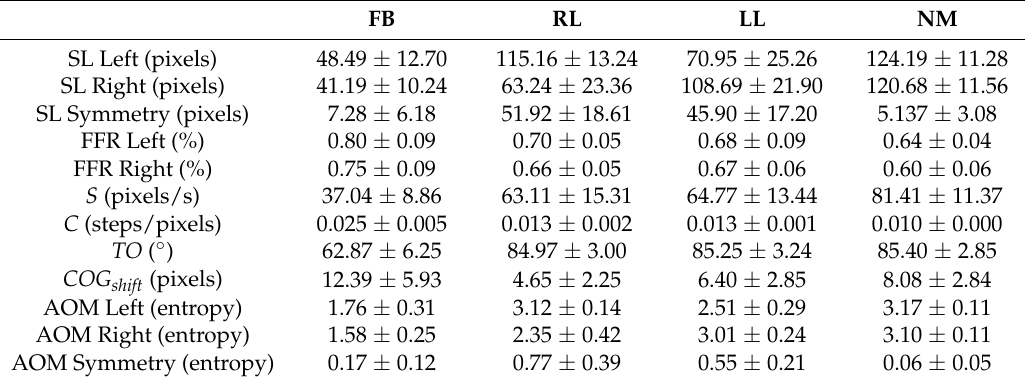
Table 2. Mean and standard deviation of all the observed gait features belonging to different groups.